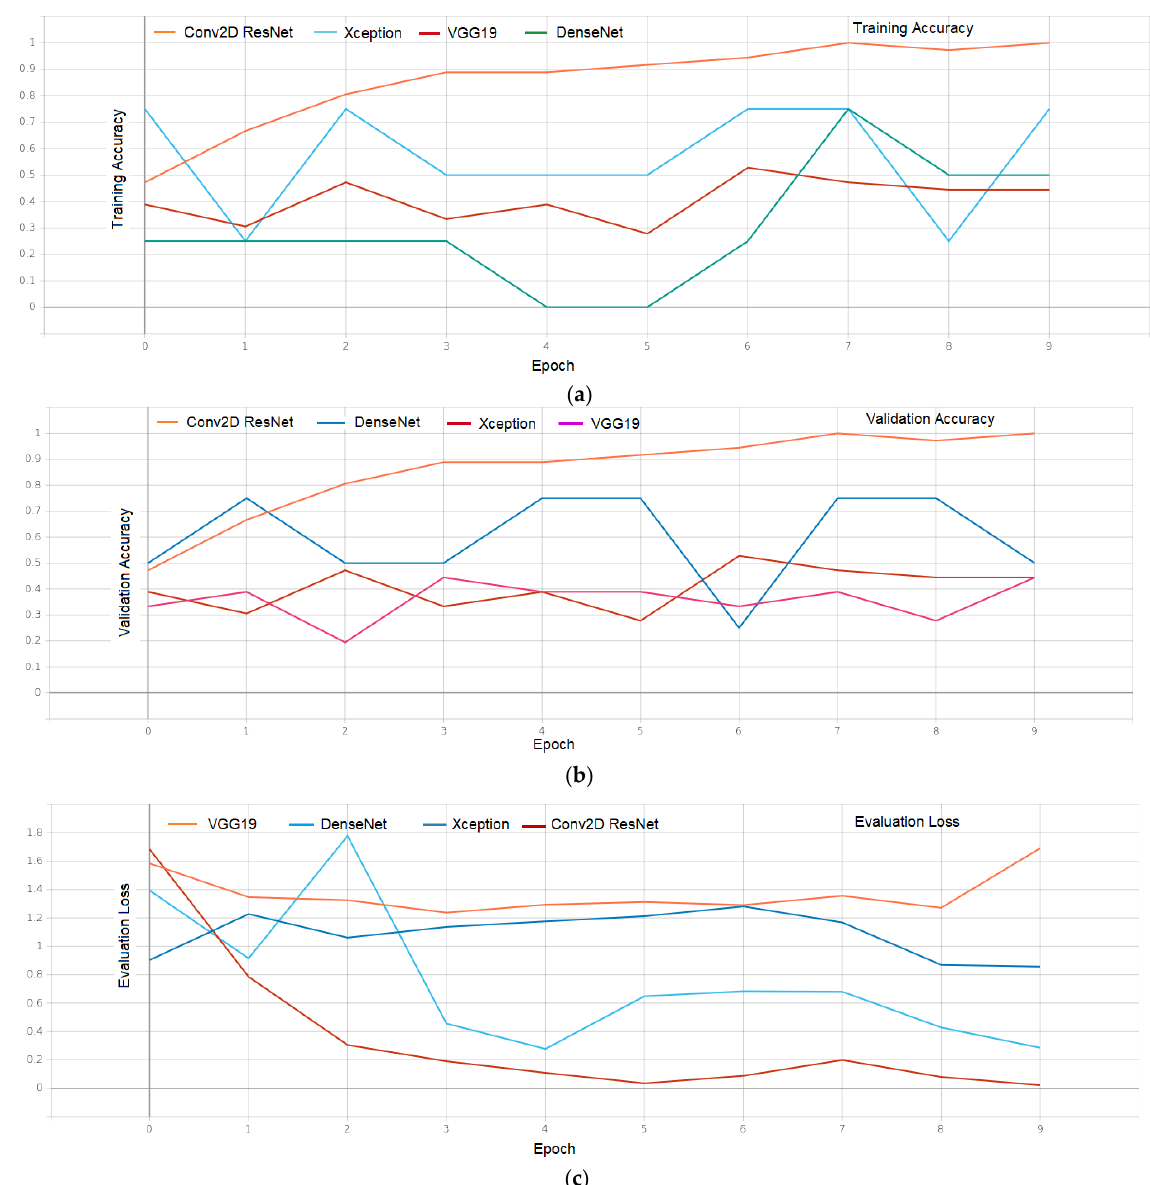
Figure 12. Learning curve comparisons of Conv2D models. ( a ) Training accuracy; ( b ) validation accuracy; ( c ) evaluation loss.